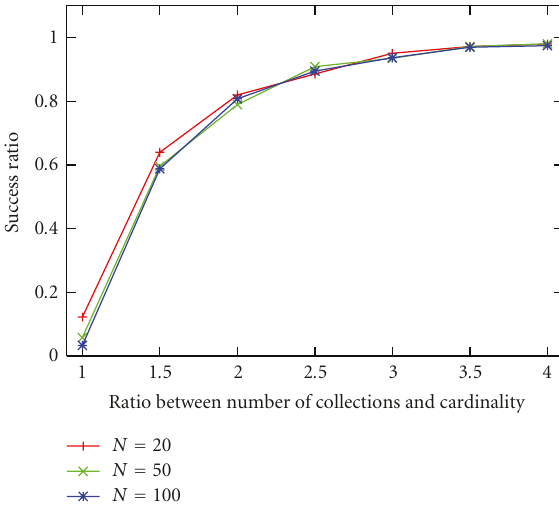
Figure 7: Success ratio as a function of M with di ff erent bu ff er size.